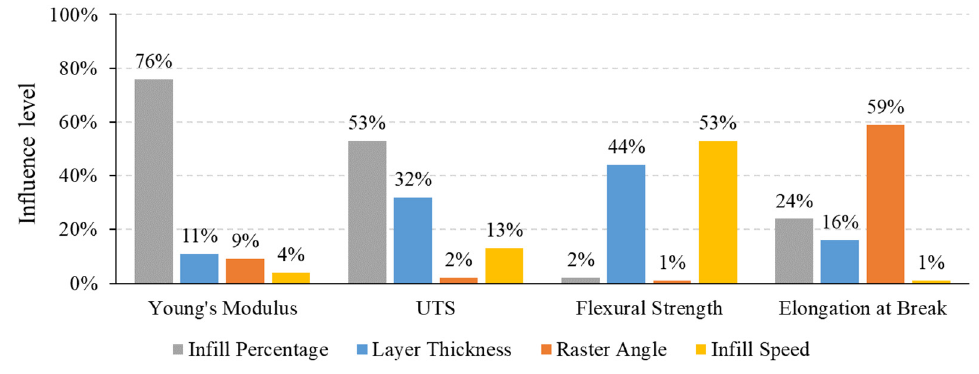
16 of 21 Figure 20. PETG ( a ) strength and ( b ) Young’s modulus sensitivity to printing speeds with different raster angles (in degrees). 6.5. PETG Mechanical Properties Sensitivity Study Using ANOVA The range for each process parameter is summarized in Table 8. Figure 21 shows that Young’s modulus is significantly affected by infill percentage. UTS is mainly affected by infill percentage and layer thickness. Additionally, flexural strength is greatly affected by printing speed and layer thickness. Elongation at break is determined by raster angle and infill percentage. The process parameters are ranked in Table 9 according to their influ ‐ ence on the specified PETG mechanical properties. Table 8. Process parameters range used for PETG material along with the related settings